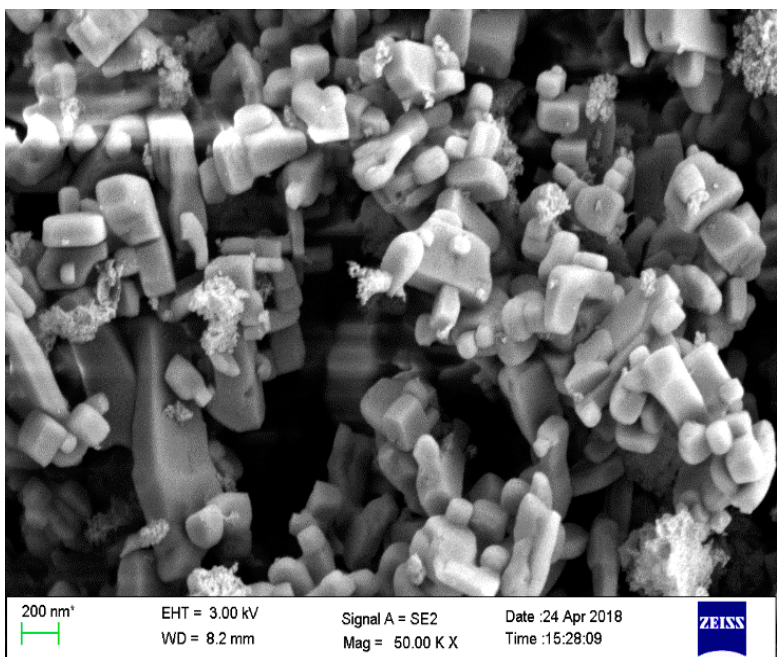
Figure 4. FESEM micrograph of zeolite particles synthesized from ISA [66] [Patent no 202011036844 A].